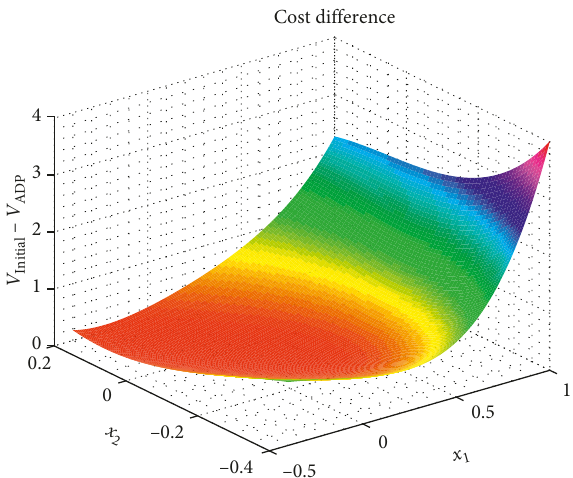
Figure 2: Cost difference between initial admissible control and approximated optimal